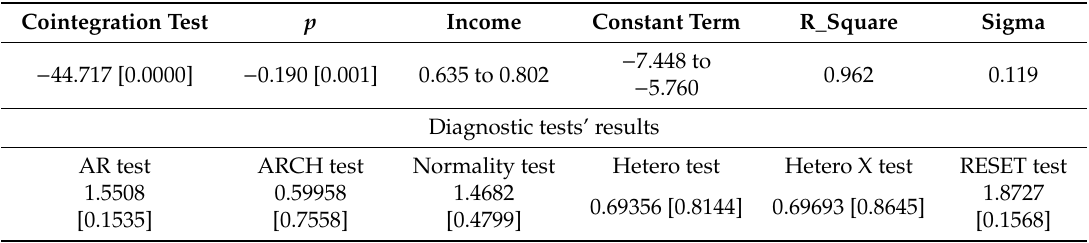
Table 8. MIS long-run estimation results.